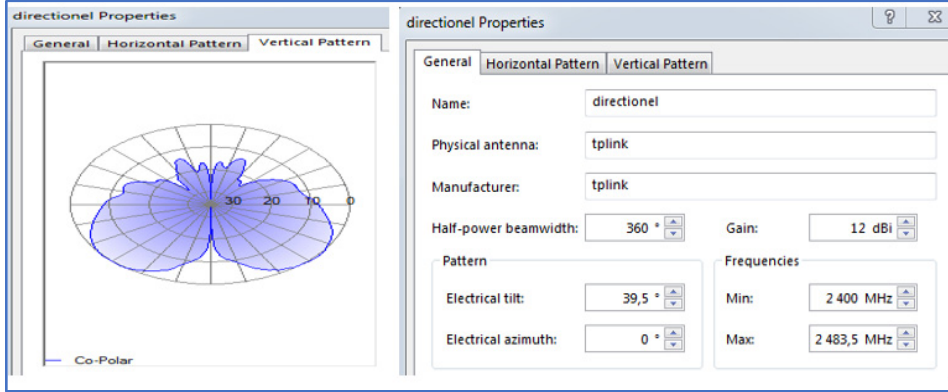
Figure A2. The introduction of frequency and the creation of a new type of Wi-Fi antenna.